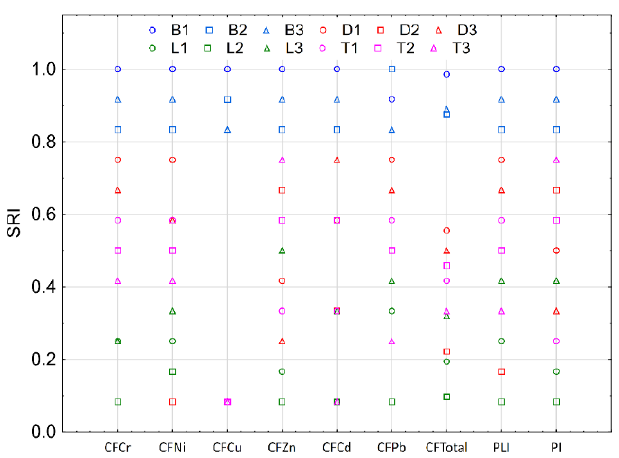
Figure 3. SRI values for indices of river bottom contamination.